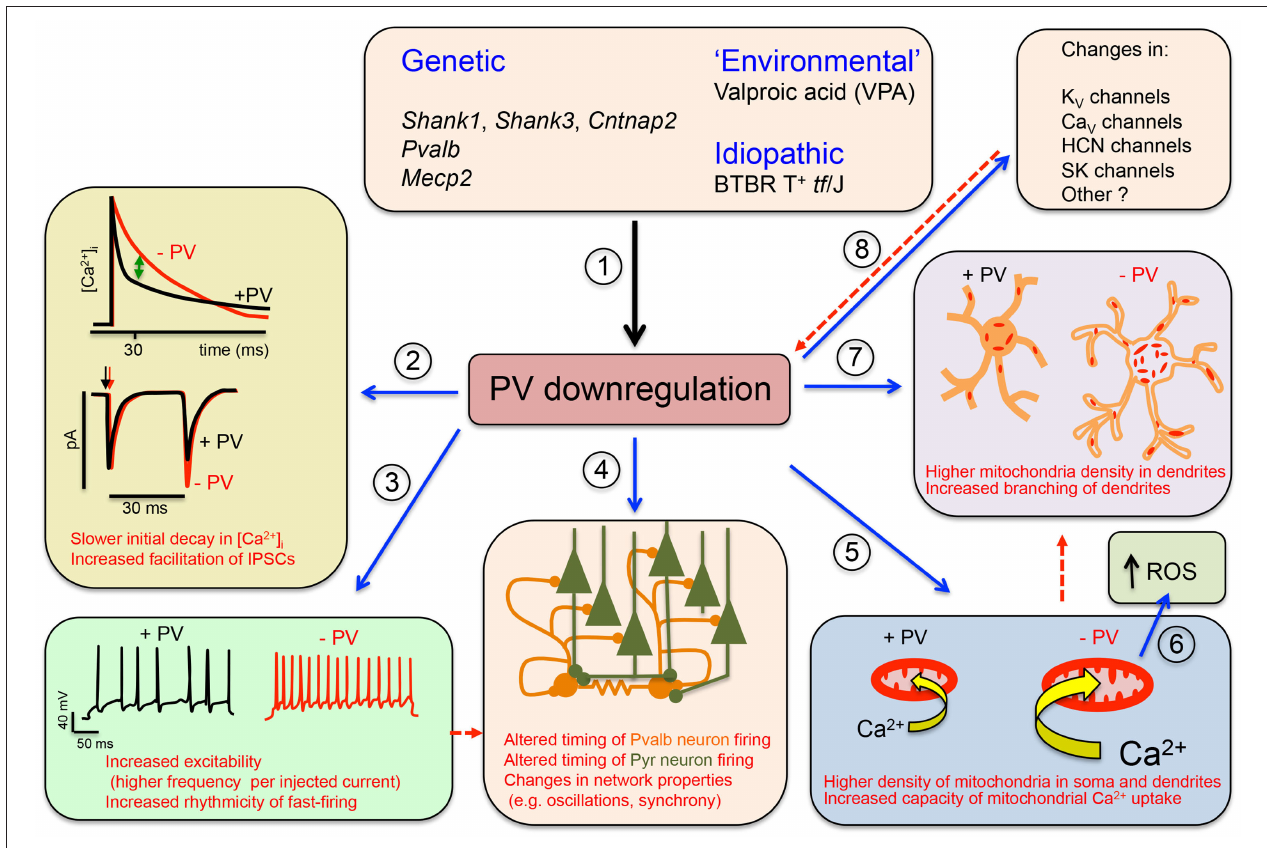
FIGURE 1 | Graphical summary of the Parvalbumin Hypothesis of autism spectrum disorder (ASD) (and putatively, of schizophrenia). (1) Genetic and environmental factors directly or indirectly affecting Pvalb neuron function in mice through impairment of principal neurons, leading to the downregulation of parvalbumin (PV) and reduced neuronal function. (2) (Upper) The initial decline in [Ca 2 + ] i in Pvalb neurons is accelerated in the presence of PV. Differences in the decay curves ( ± PV) are largest in the time window of ∼ 20–50ms after peak [Ca 2 + ] i , resulting in increased residual Ca 2 + in the absence of PV (green arrow). (Lower) Larger amounts of residual Ca 2 + promote γ -aminobutyric acid (GABA) release during further stimulation in this time window, leading to increased facilitation in the paired-pulse protocol. (3) An absence of PV alters other electrophysiological properties: for example, it may increase the excitability of Pvalb neurons, or may result in more regular firing within AP trains (i.e., reducing “jitter”) (modified from Orduz et al., 2013). (4) A decrease in PV level affects the electrophysiological properties not only of Pvalb neurons but also of principal (pyramidal) cells and modifies network properties such as oscillation and synchrony. (5) A decrease in PV level alters Ca 2 + -dependent excitation/transcription coupling by reducing transcript levels of activity-driven genes including Pvalb and Gad1 and prototypical neuronal-activity-associated genes such as c-Fos , Arc , and Wnt2 ; it also increases messenger RNA (mRNA) levels of genes involved in mitochondrial biogenesis such as Ppargc1a encoding the mitochondria master regulator PGC-1 α , as well as Nrf1 and Tfam . This results in an increase in mitochondrial volume (density) that is approximately proportional to the PV concentration in corresponding wild-type (WT) Pvalb neurons—i.e., the higher the PV concentration, the greater the increase in mitochondrial density in PV − / − Pvalb neurons. (6) Increased mitochondrial volume associated with a decrease in PV level enhances mitochondrial Ca 2 + -buffering/sequestration capacity, thereby promoting reactive oxygen species (ROS) production. This slow process may impair mitochondrial function and ultimately impacts Pvalb neuron function, which is thought to produce a schizophrenia phenotype. (7) Absence of PV during (early) postnatal neurodevelopment from ∼ PND7 to PND20 increases dendritic branching, yielding Pvalb neurons with a larger dendritic tree and possibly resulting in hyperconnectivity. Increases in mitochondria number and dendritic branching caused by PV downregulation may be subsequent events (red dashed arrow) or could occur via independent mechanisms. (8) Absence of PV perturbs the expression of other putative ASD susceptibility genes that are either directly associated with the electrophysiological properties of Pvalb neurons or are expressed in pyramidal cells that influence Pvalb neuron circuitry; this includes K V , Ca V HCN channels, and SK channels. Whether targeted inhibition of these genes also affects PV level is unknown. Solid arrows indicate a causal relationship between events—e.g., altered Ca 2 + concentration ( ± PV) and short-term modulation of synaptic plasticity. Dashed lines indicate putative (indirect) mechanism(s) via as yet unknown pathways. Points (1)–(8) are described in detail in the main text (see all subsections in Data Supporting the Parvalbumin Hypothesis of ASD ).